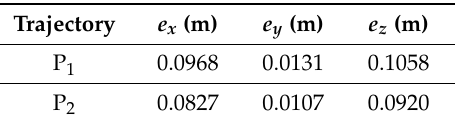
Figure 24. P 2 tracking responses: ( a ) 6-DOF responses; ( b ) Link angles. Table 3. The tracking errors for proposed closed loop control system: P 1 and P 2 indicate the generated 3D path trajectories.